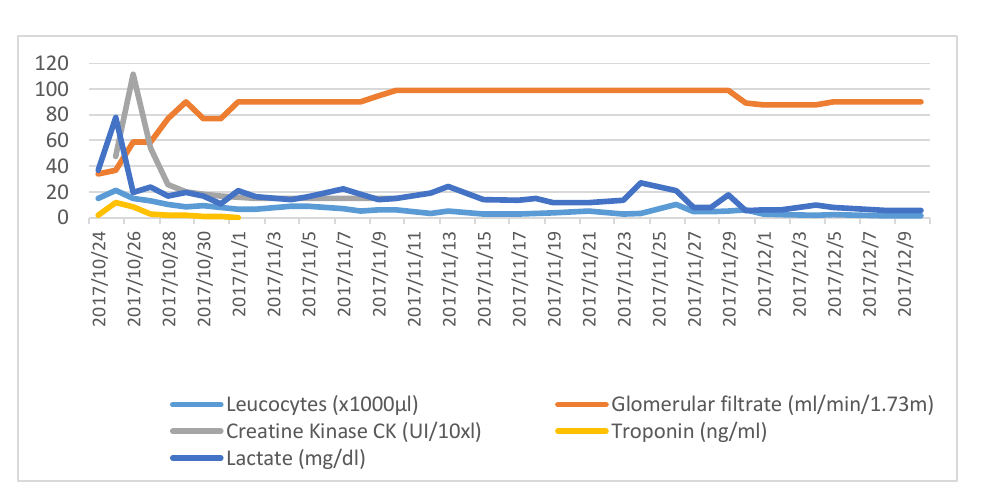
Figure 1. Changes of the main lab parameters solicited during the stay.